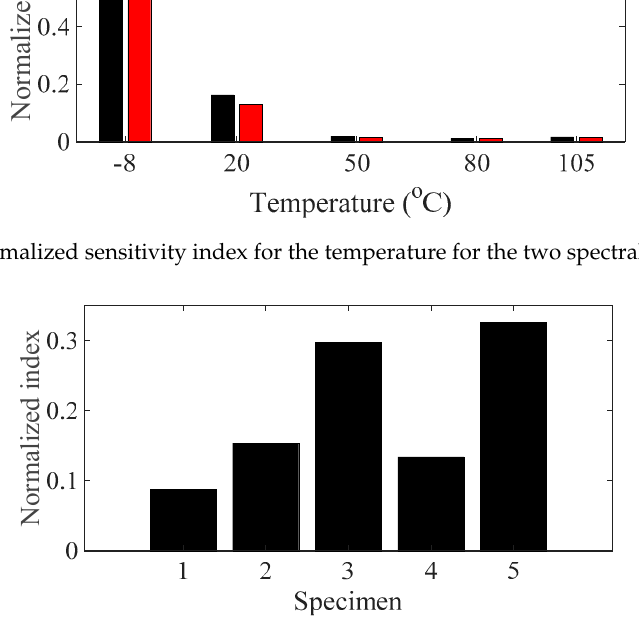
Figure 16. Normalized sensitivity indices for the spectral loading pattern.